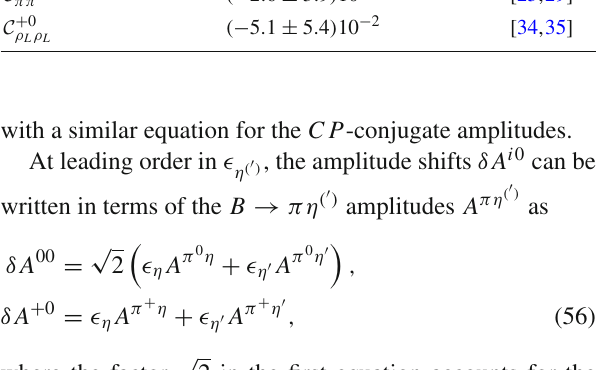
Table 10 World averages for the C + 0 direct CP asymmetries for the B → π + π 0 decay and for the longitudinally polarised state in B + → ρ + ρ 0 decay Observable World average Reference C + 0 ππ [25,29]